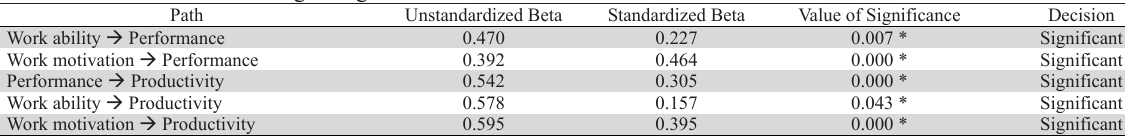
Results of the Direct Effect Weight